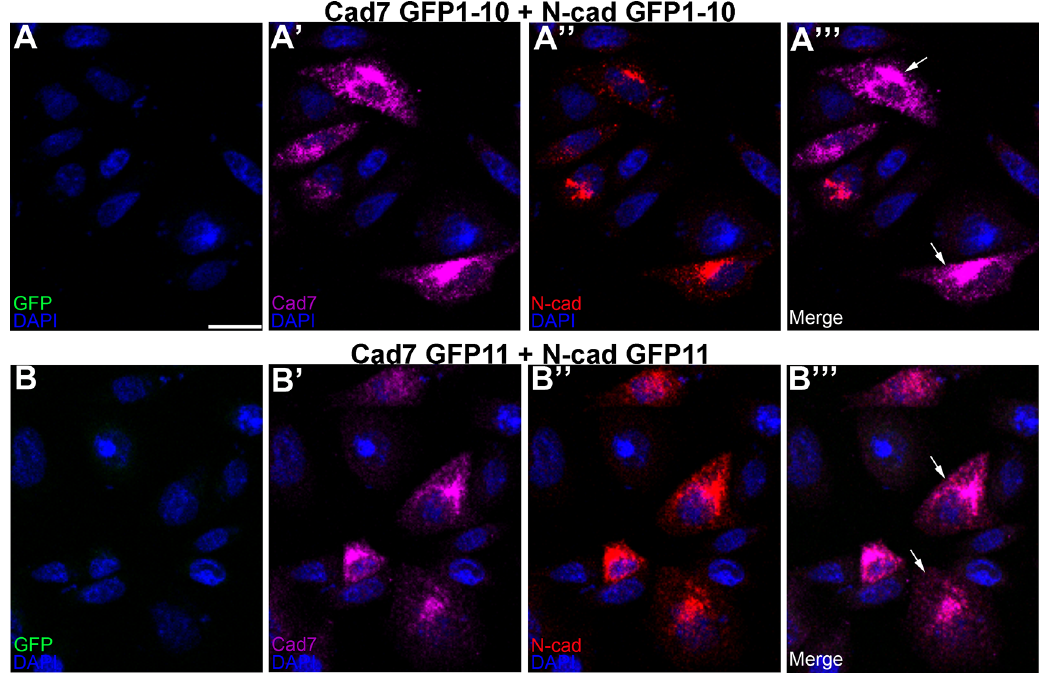
Figure 4. Different cadherin-expressing GRASP constructs possessing the same GFP domains do not recon- stituteGFP. Co-transfectionofCHOcellswithCad7GFP1-10+N-cadGFP1-10(A-A ”’ ),orCad7GFP11+N-cadGFP11(B- B ”’ ), was performed, followed by immunocytochemistry for Cad7 (A ’ , A ”’ , B ’ , B ”’ , purple) and N-cad (A ” , A ”’ , B ” , B ”’ , red). GFP fluorescence was also examined in the appropriate microscope channel (488) but not observed. Arrows point to cadherin expression in co-transfected cells. DAPI (blue), cell nuclei. Scale bar in (A) is 50 μ m and applies to all images. N=8 replicates for both treatments. GFP, green fluorescent protein; GRASP, GFP reconstitution across synaptic partners; CHO, Chinese hamster ovary; N-cad, neural cadherin; Cad7,